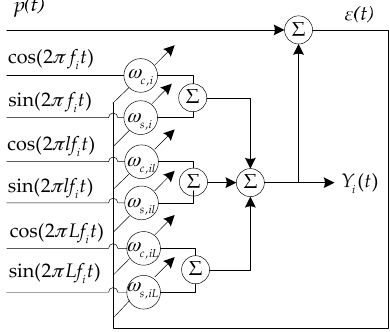
Figure 3. The principle of harmonic cluster adaptive line spectrum enhancer.